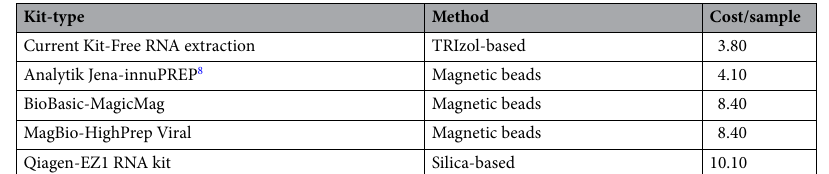
Table 1. Cost comparison of RNA extraction methods with high-throughput approach. The cost (USD) per sample includes laboratory consumables such as tips and reagents, but excludes the cost of instruments.